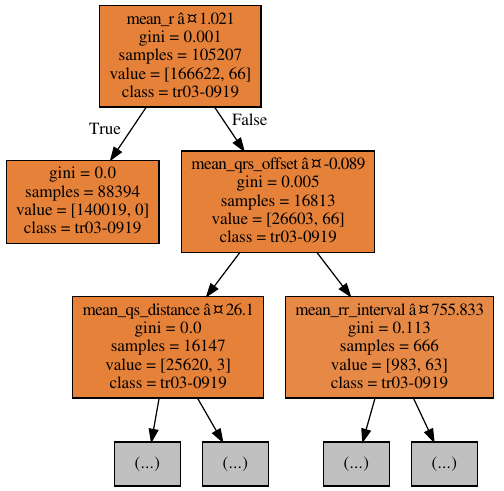
Figure 4. Part of a decision tree from one of the one-vs-all model random forest base